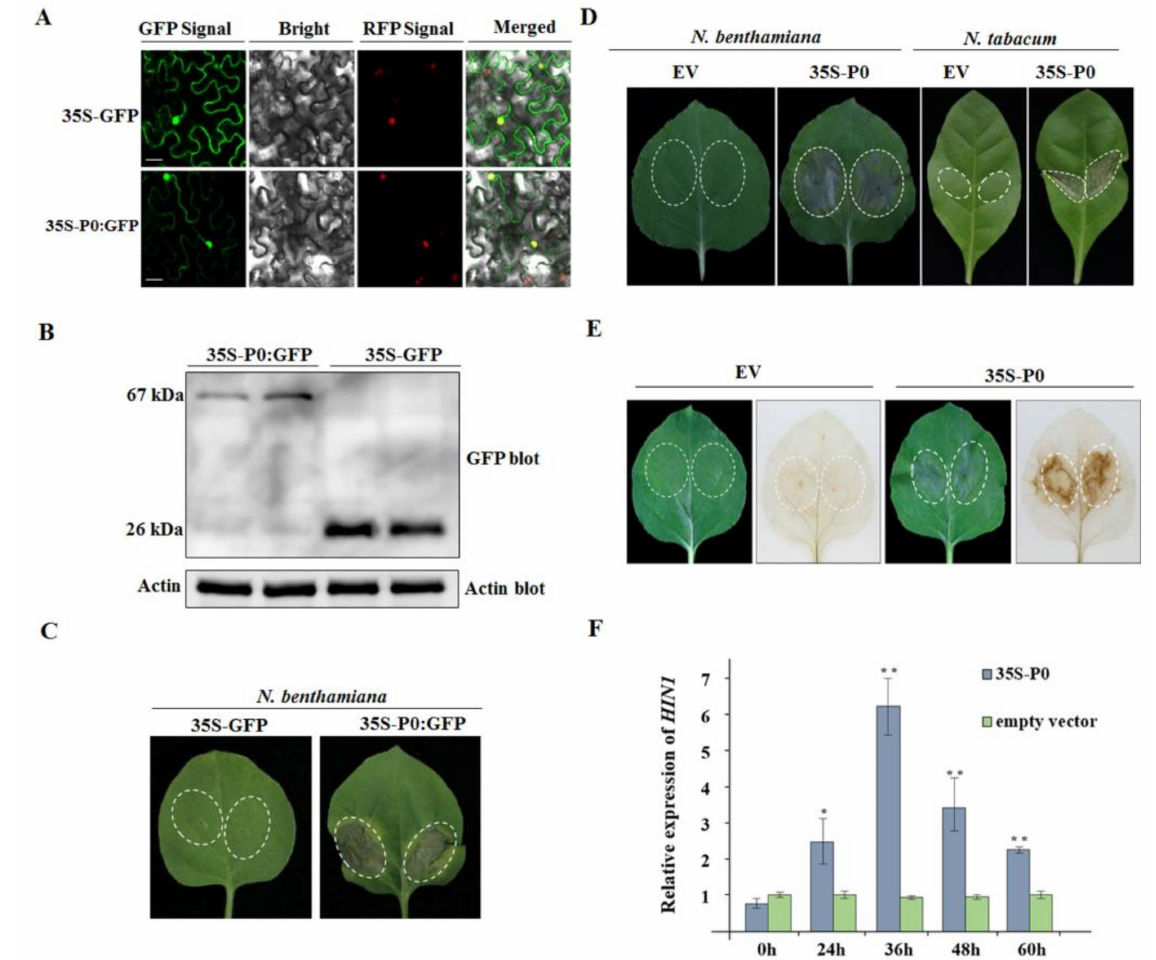
Figure 7. HR-like response induced by transient expression of CVEV-DT1 P0 in N. benthamiana leaves. ( A ) Subcellular localization of CVEV-DT1 P0 protein in H2B transgenic N. benthamiana inoculated with 35S-P0:GFP constructs at 36 h post-infiltration. ( B ) Detection of the expression of P0-GFP fusion protein by Western blotting. ( C ) HR-like cell death induced by P0-GFP fusion protein in N. benthamiana . ( D ) HR-like cell death induced by P0 protein in N. benthamiana and N. tabacum leaves inoculated with 35S-P0 constructs at 3 days post-infiltration (dpi). ( E ) Detection of H 2 O 2 accumulation in N. benthamiana leaves inoculated with 35S-P0 constructs at 2 dpi by 3,3-diaminobenzidine (DAB) absorption method. ( F ) Analysis of the transcriptional level of HIN1 in N. benthamiana leaves inocu- lated with 35S-P0 constructs by qRT-PCR. Asterisks (* or **) indicate levels of significant difference ( p ≤ 0.05 or p ≤